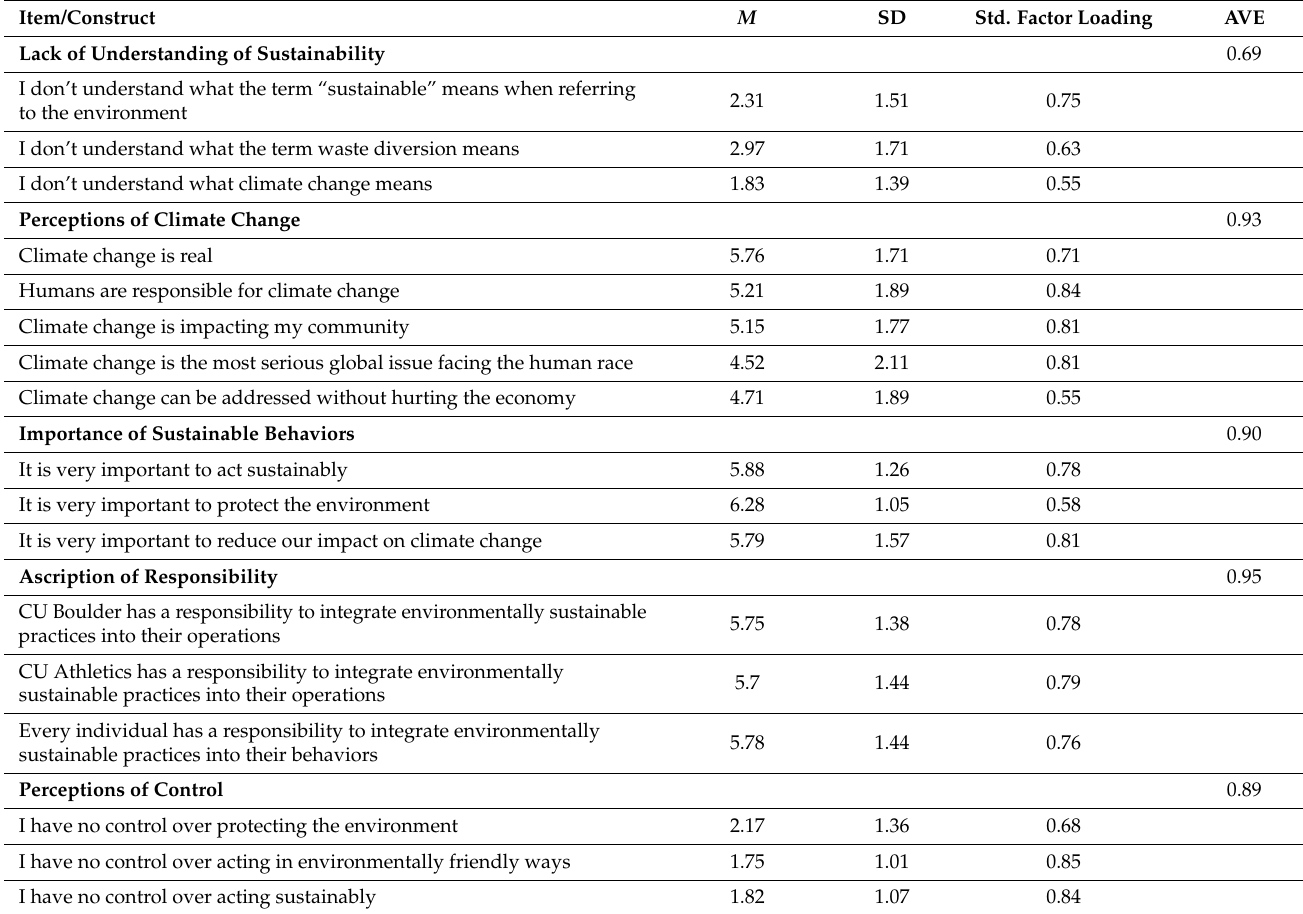
Table 1. Items and